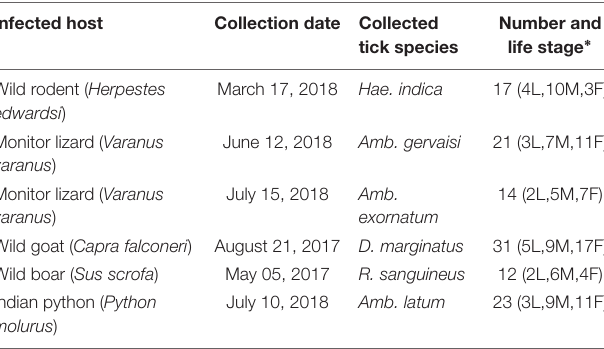
TABLE 4 | Tick species collected from wild animals during this